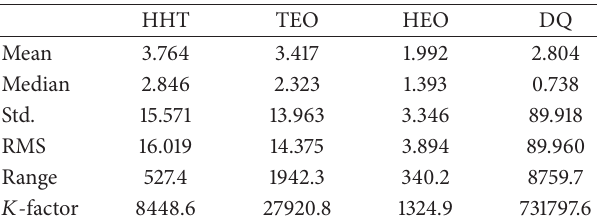
Table 1: Statistical variables of extracted